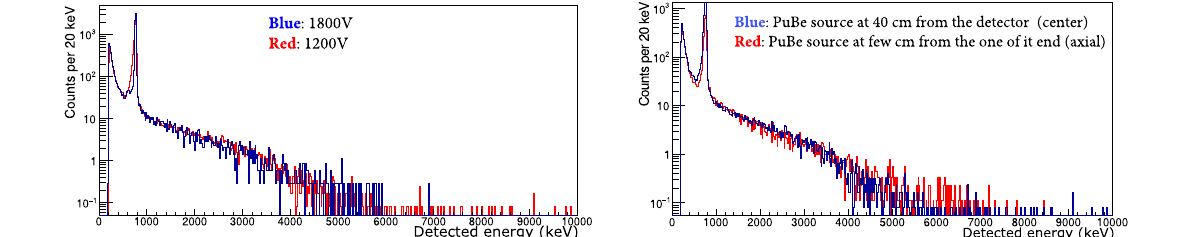
amplification gains differ by a factor of about 6. Right: same as left panel but with a fixed voltage of 1200 V and the neutron source either irradiating the counter along its axial (red) or radial axis